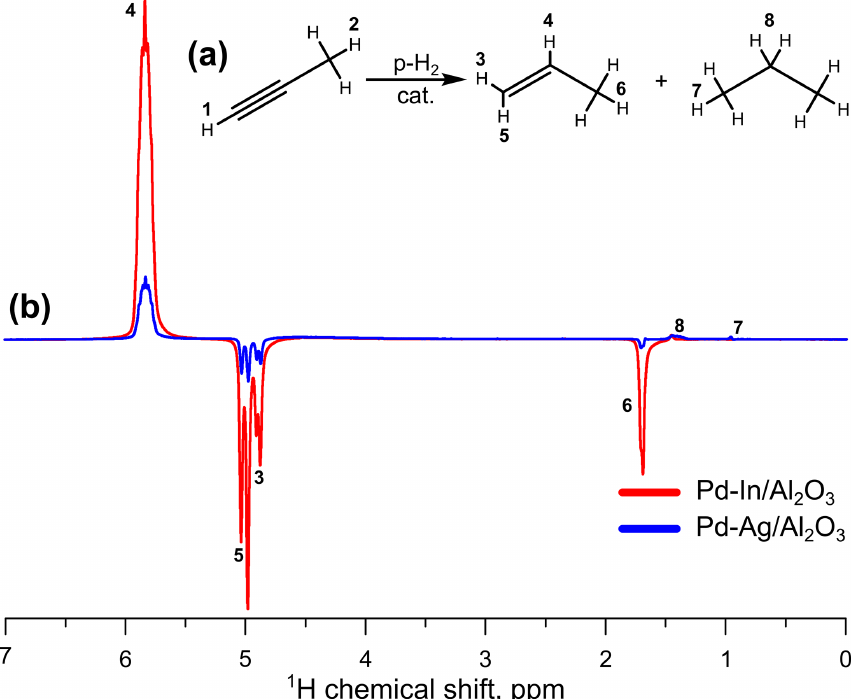
Figure 2. (a) Reaction scheme of propyne hydrogenation; (b) 1 H NMR ALTADENA spectra acquired during propyne hydrogenation with parahydrogen over the Pd-In / Al 2 O 3 (red line) or Pd-Ag / Al 2 O 3 (blue line; the same spectrum as in Fig. 1) catalysts. The reaction temperature was 200 ◦ C, and the total gas flow rate was 3.8mLs − 1 . All spectra were acquired with eight signal accumulations and are presented on the same vertical